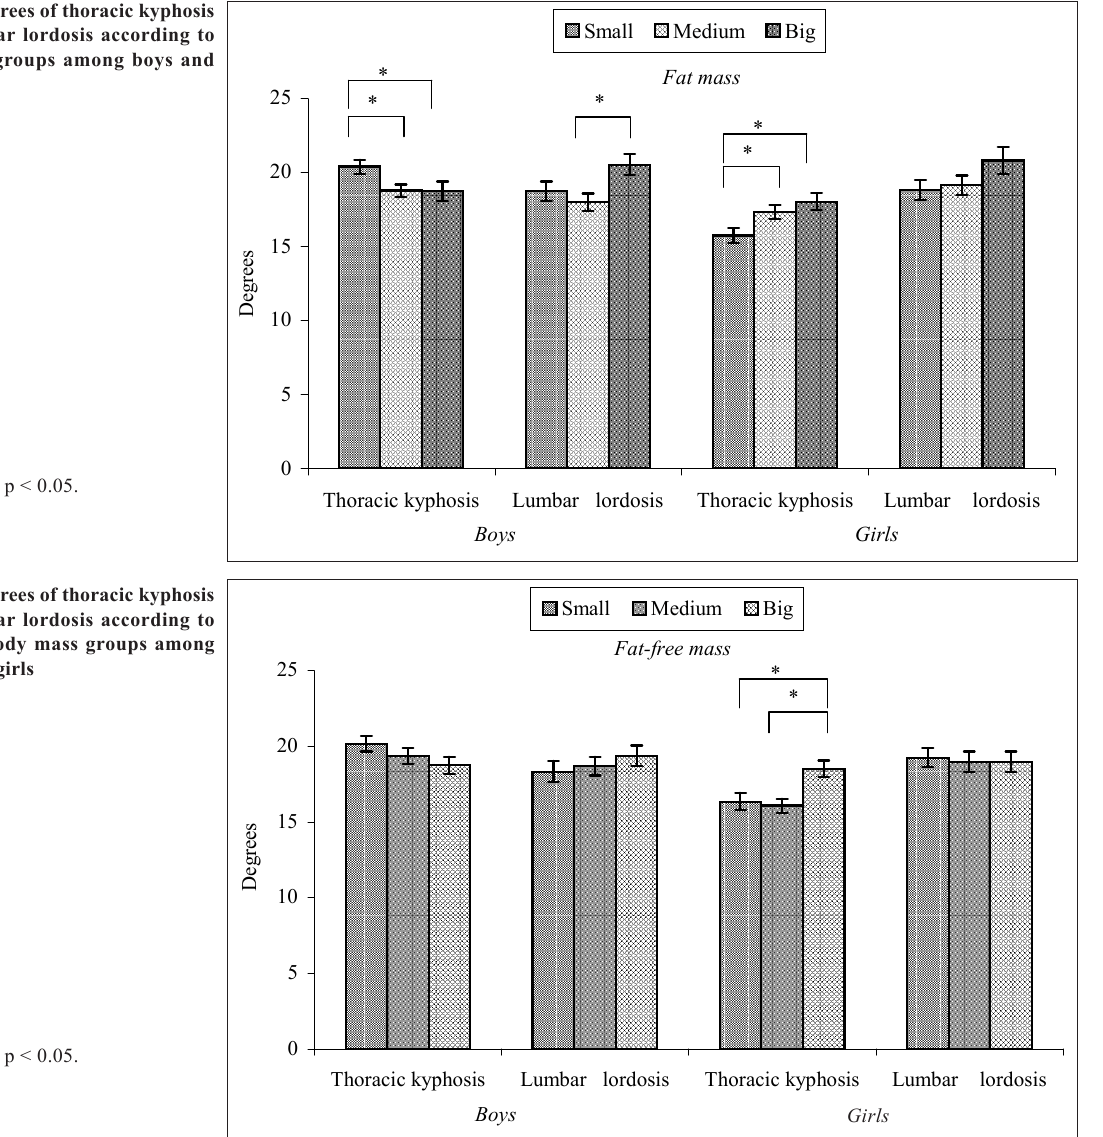
fat mass. Girls with small amount of fat mass had minimal kyphosis and lordosis values. The analysis revealed no significant differences between lordosis mean values and different fat-free body mass groups in both gender groups. Differences were significant only in kyphosis mean values among girls. Girls with bigger fat-free body mass tended to have greater kyphosis values (Fig. 4) than girls with medium and small fat-free body mass (p < 0.05). correlation between anthropometric and posture